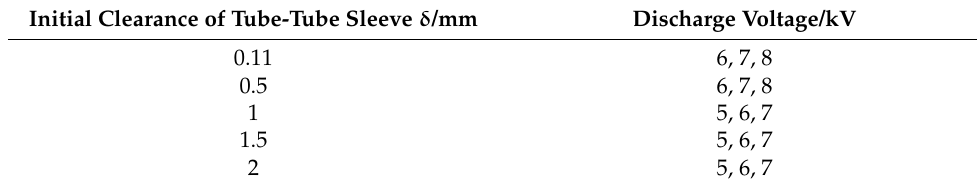
Table 2. Variable tube-tube sleeve initial gap and voltage process parameter settings.